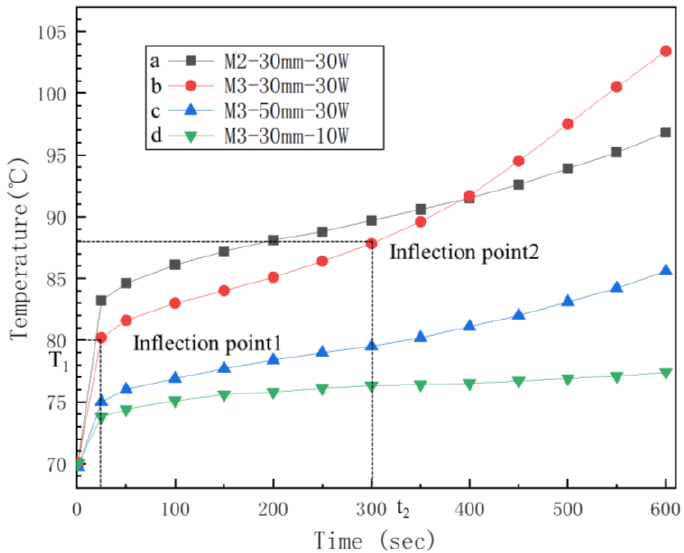
Figure 9. P erformance of each phase change module under 30 W. Figure 9. Performance of each phase change module under 30